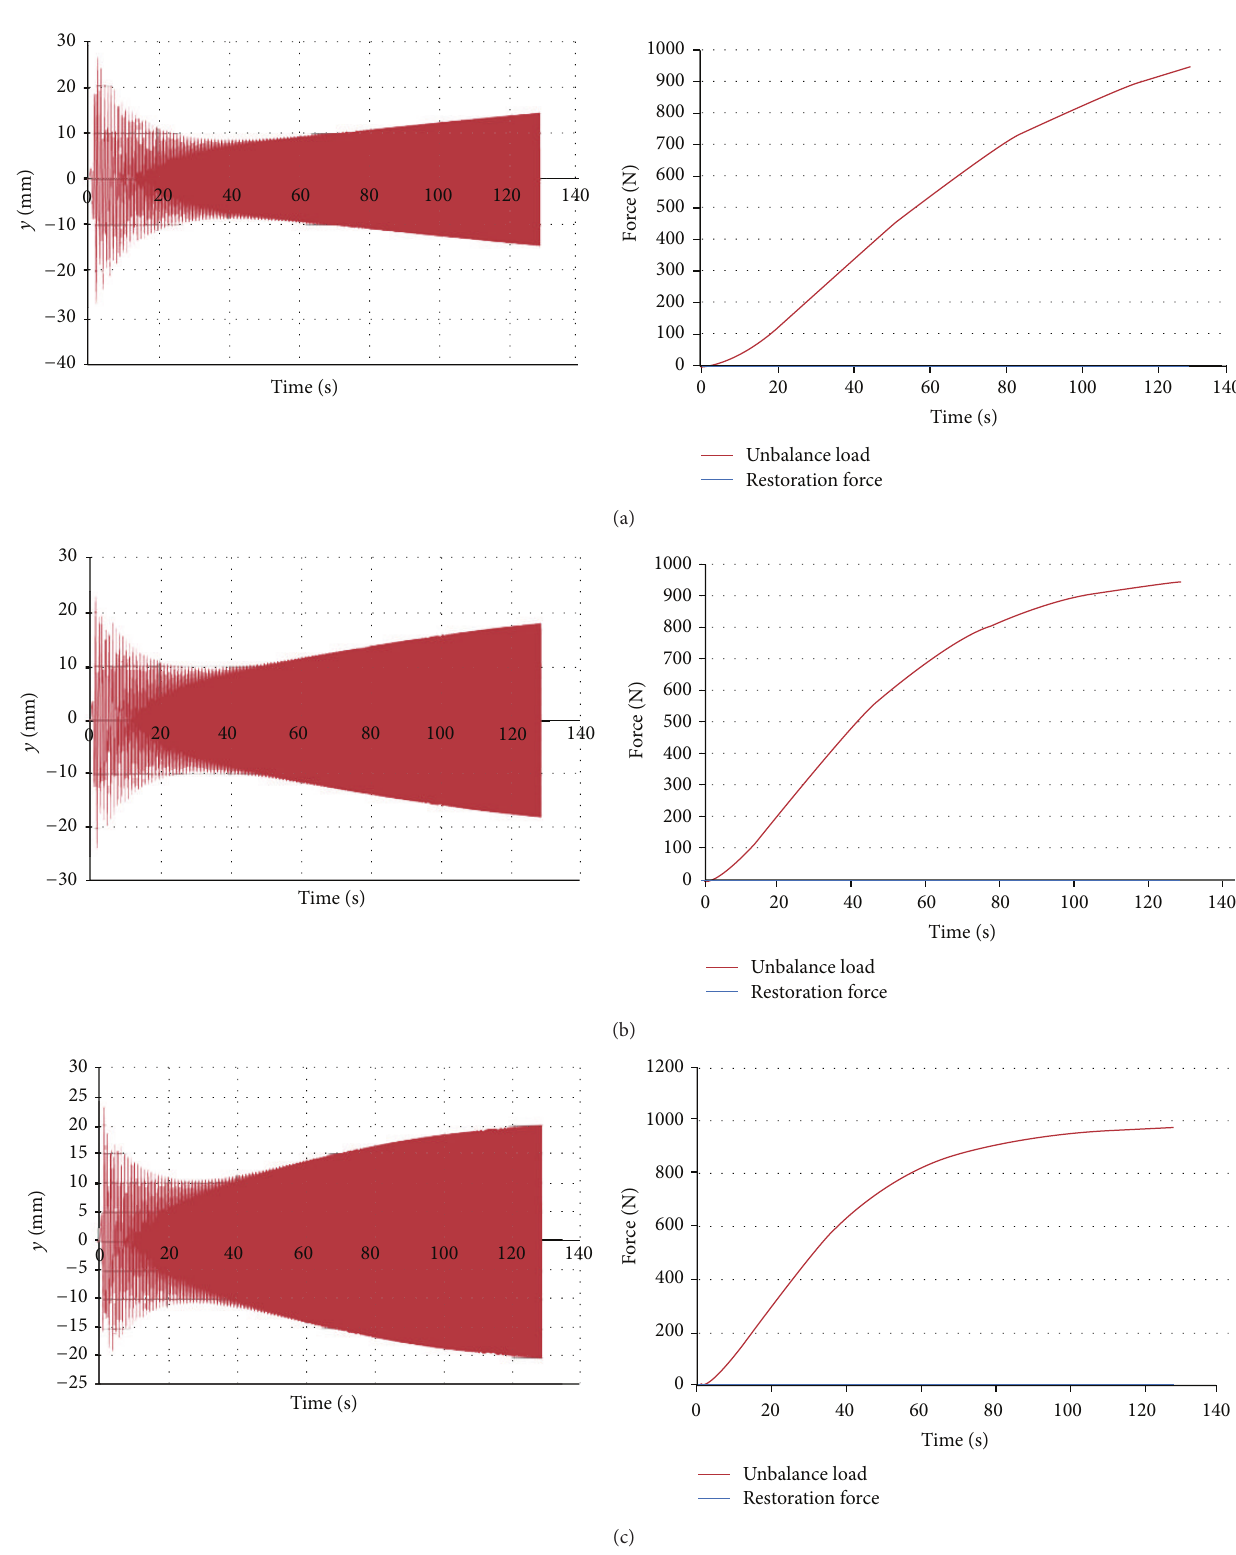
Figure 10: Diagram of orbit displacement ( 𝑦 direction) and unbalance load for system without balance ring with ramp acceleration equal to (a) 15rpm/s; (b) 20 rpm/s; and (c) 25